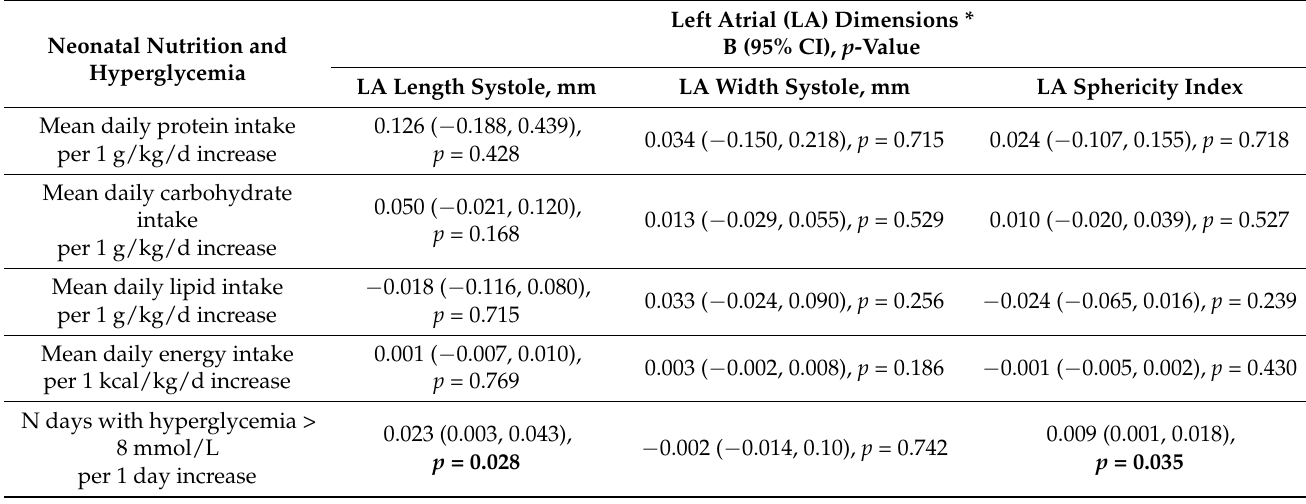
Table 3. Associations between macronutrient and energy intakes and hyperglycemia during the neonatal period with left atrial dimensions at 6.5 years of age in children born extremely